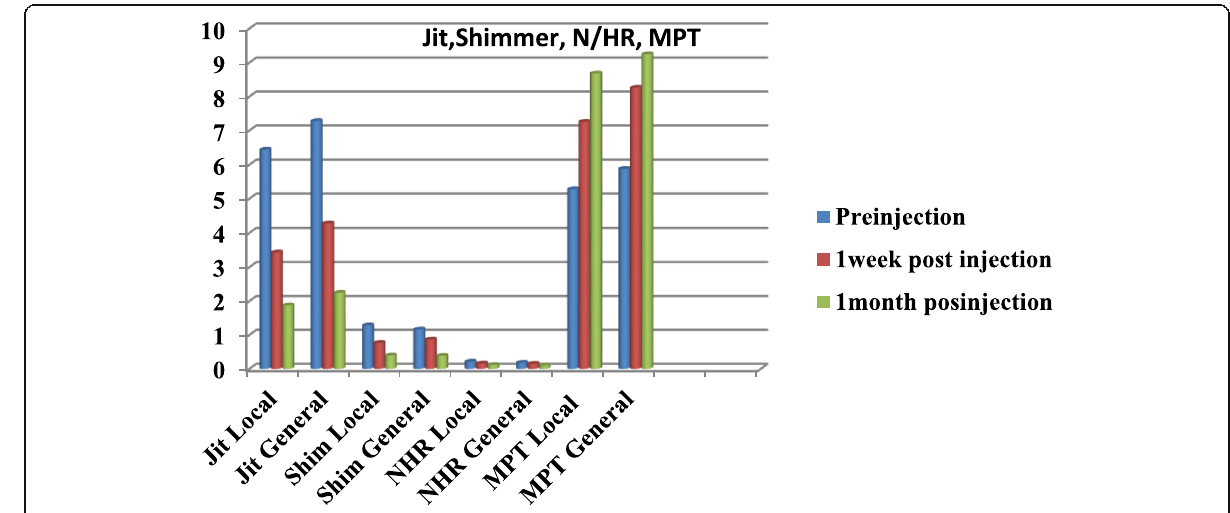
Fig. 4 Comparison between pre-injection and post-injection results of acoustic analysis by local and general